Question: Sum up the contents of this chart in one sentence.
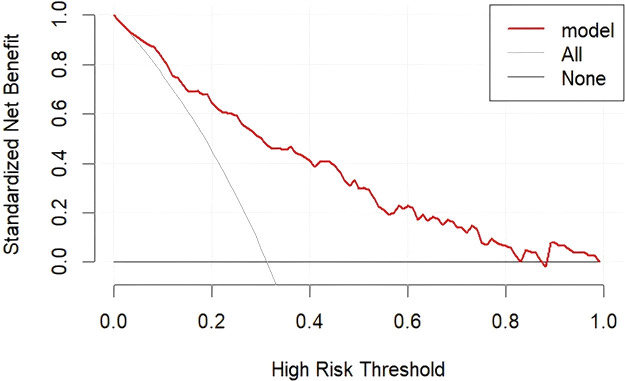
Answer: DCA of the prediction model. DCA, Decision curve analysis.